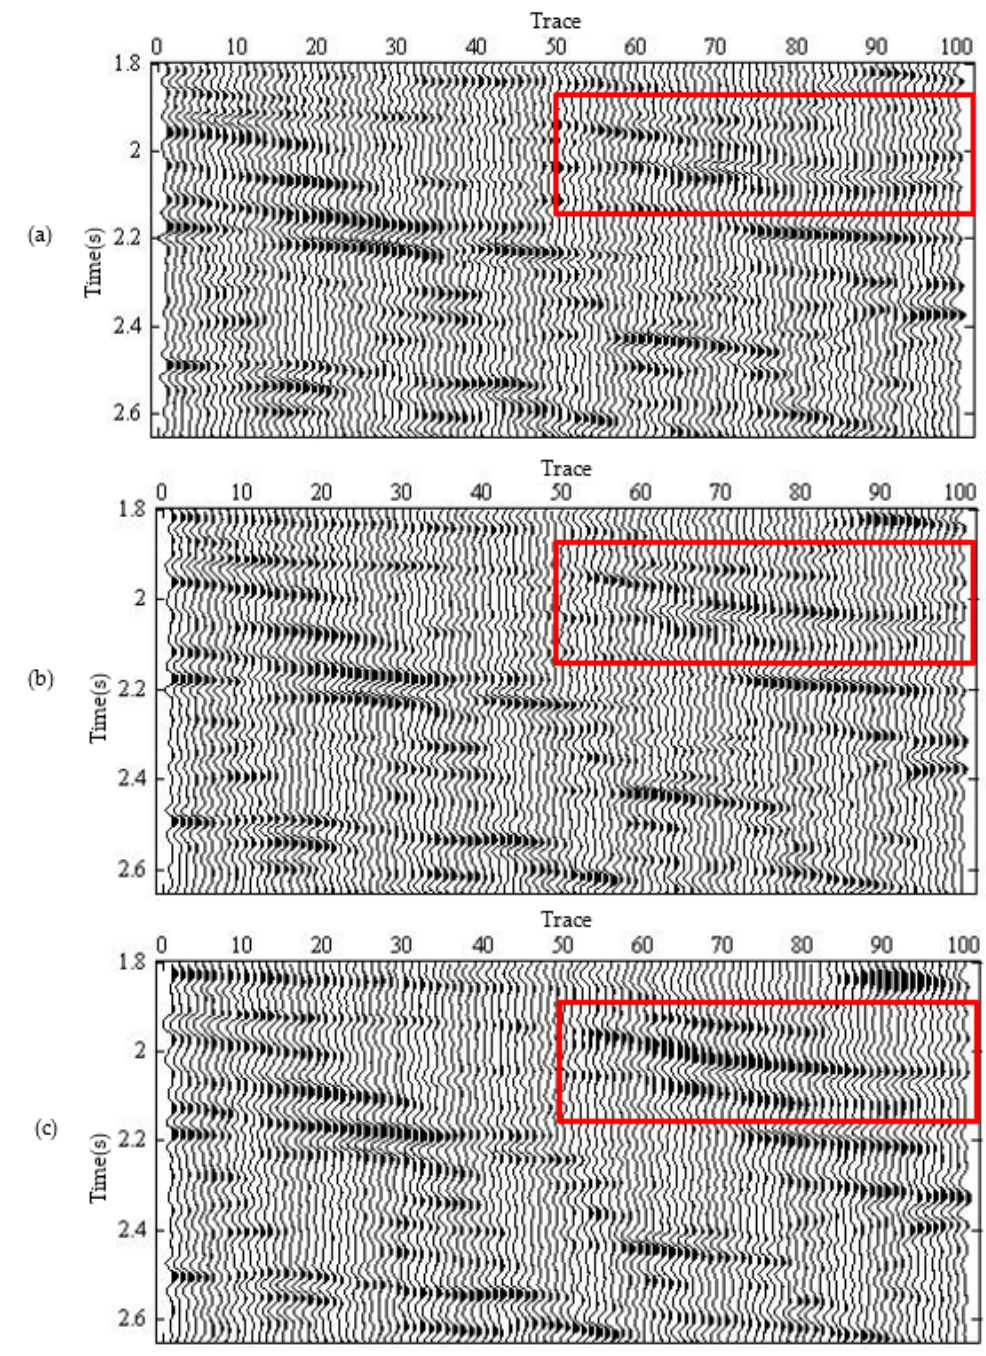
Figure 14. Filtering profile with 1–3 Hz of actual data before and after low-frequency expansion. ( a ) Original data, ( b ) processed data by CS, ( c ) processed data by the proposed method.